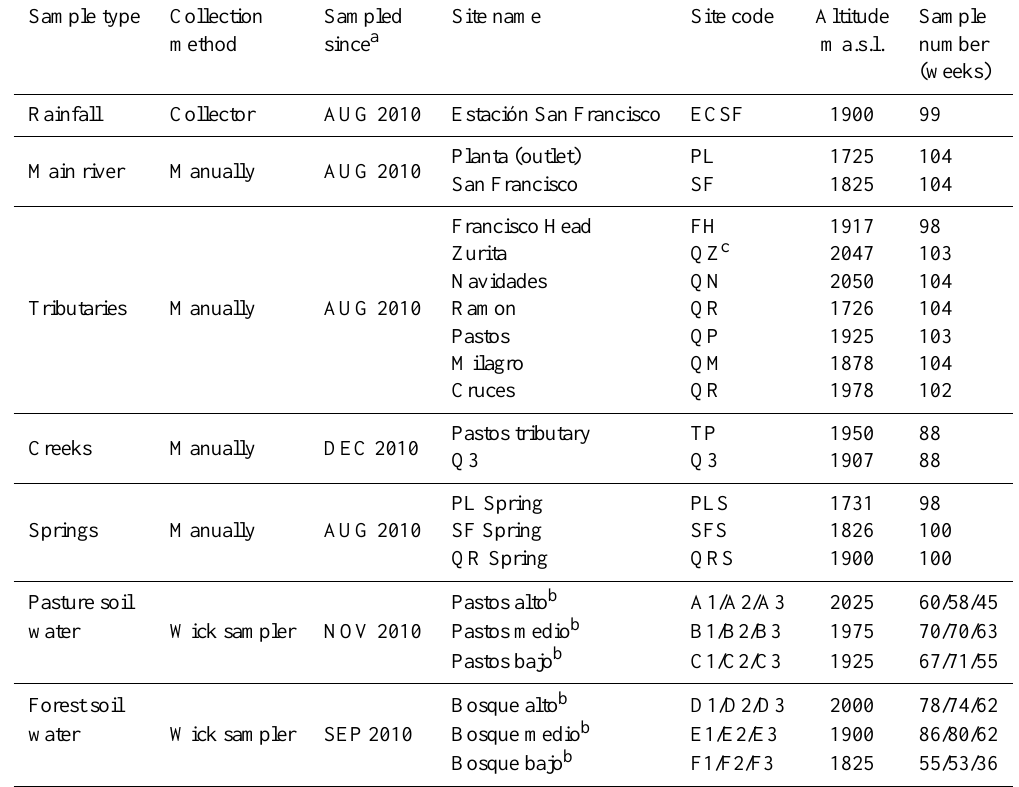
Table 2. Applied sampling strategy in the San Francisco